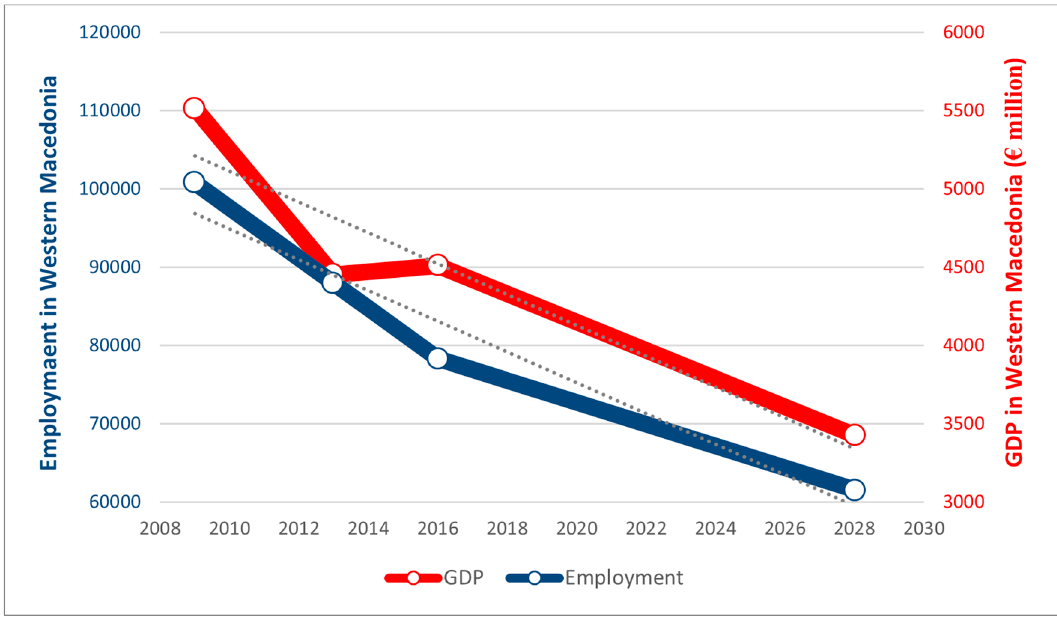
Figure 7. Forecast of GDP—employment progression in Western Macedonia.